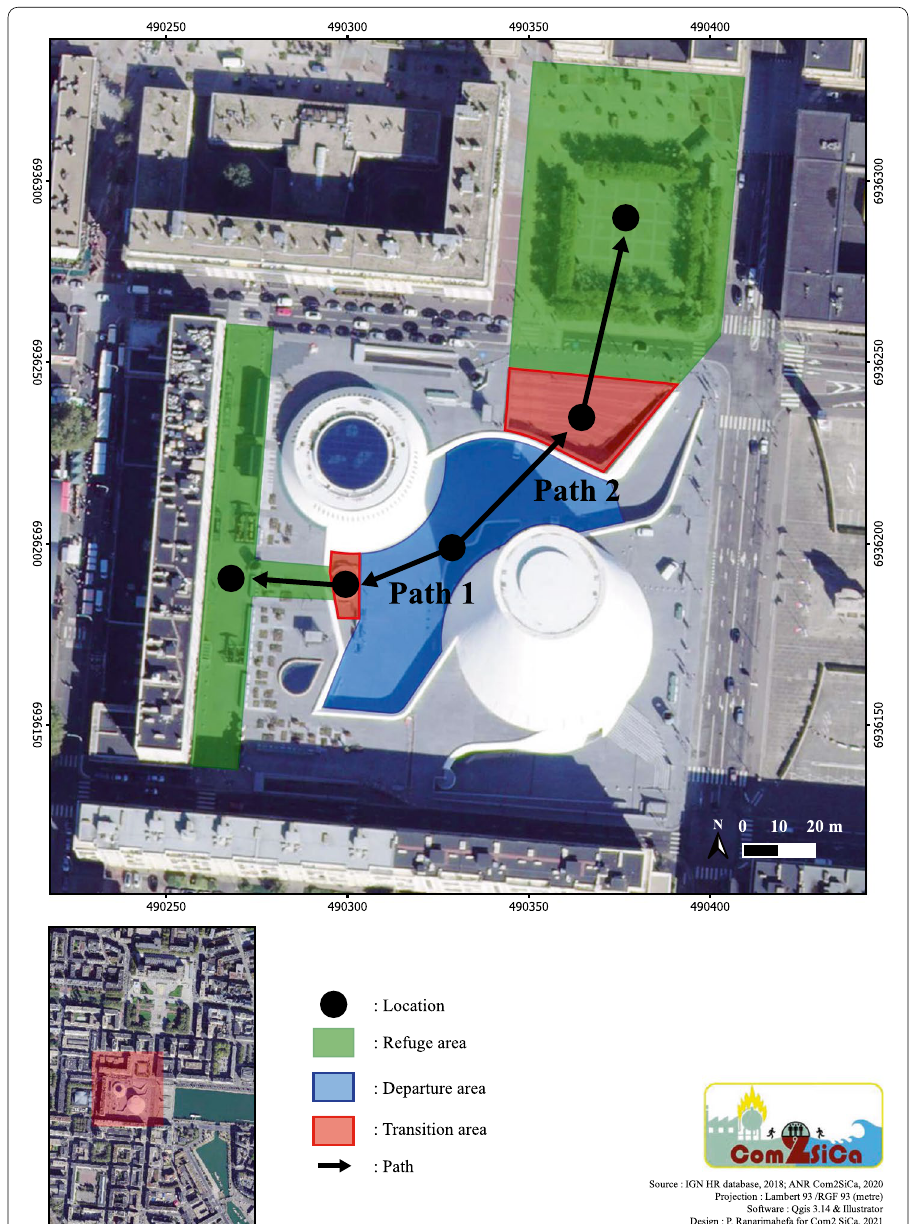
Fig. 6 Example of a subdivision of the geographical area around the Niemeyer Cultural Centre in Le Havre (France). The information on the escape routes chosen by the interviewees (Fig. 3) have guided the selection of the sub‑regions. In particular, five sub‑areas, being the nodes of our network, have been